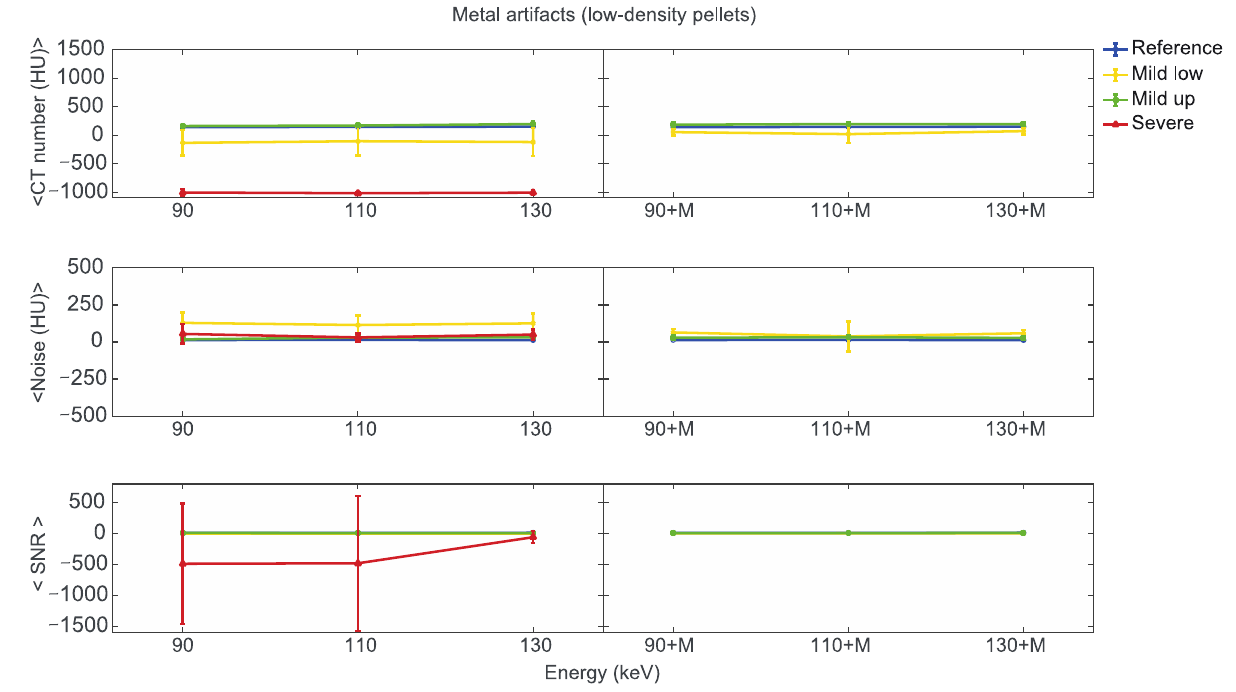
Figure 7. Mean CT number, noise, and SNR for low-density pellets of classified artifacts as a function of the reconstructed images, i.e., VMI without (90, 110, 130) and with the MARS algorithm (90+M, 110+M, and 130+M). The values for mild low, mild up, and severe artifact are reported with yellow, green, and red lines, respectively. The reference values are indicated with a blue line.